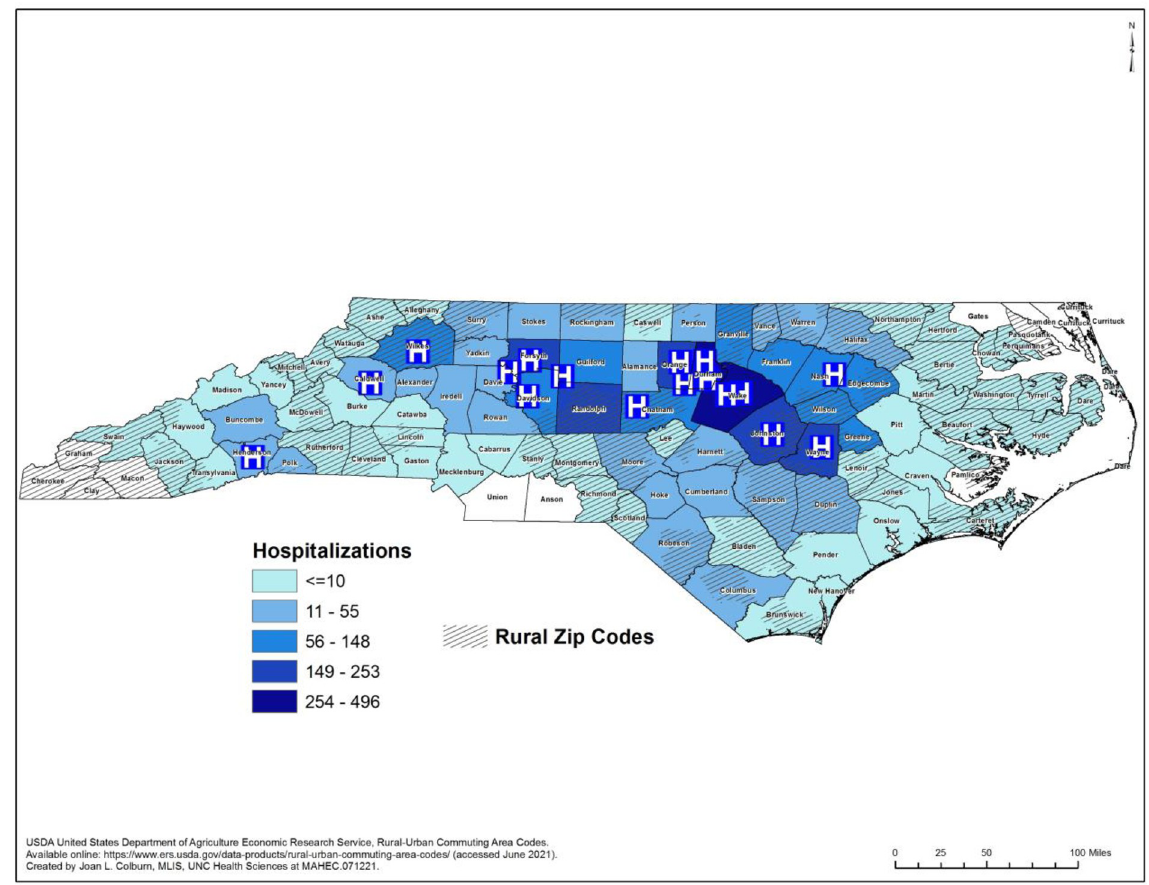
Fig 1. Map of hospitalizations by rural and urban zip codes. Map of rural and urban zip codes with the number of COVID-19 hospitalizations per county between March 1 and September 30, 2020. Locations of hospitals included in this study are shown with an “H”.